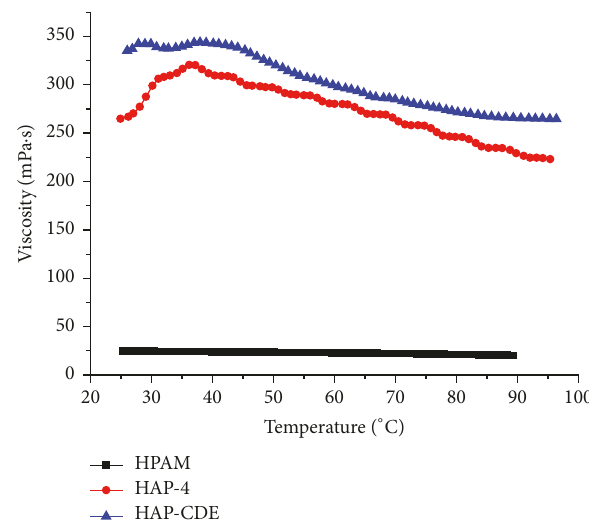
Figure 6: Viscosity as a function of temperature for the three polymeric systems (0.2 wt%, ̇𝛾 = 7.34 s −1 ). The viscosity decreases with temperature for the HPAM solution whereas the solutions for HAP-4 and HAP-CDE show fewer declines in